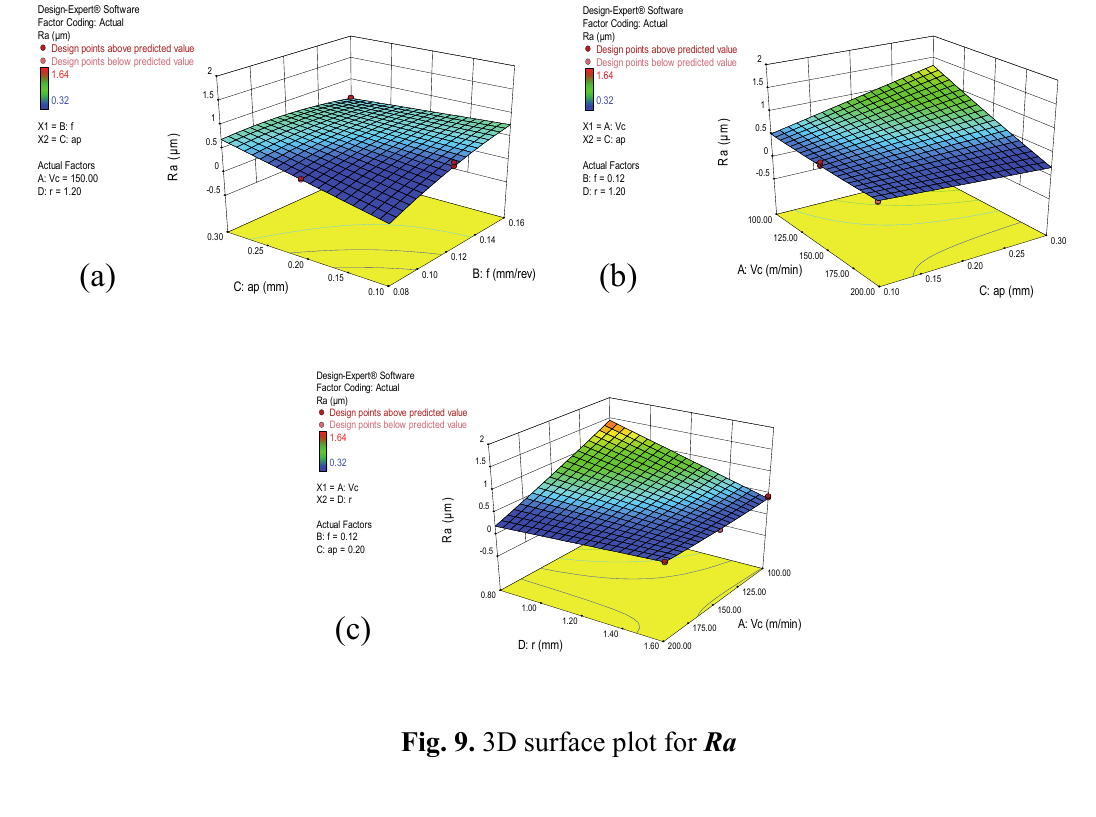
Design-Expert® Software Factor Coding: Actual Ra (µm) Design points above predicted value Design points below predicted value 1.64